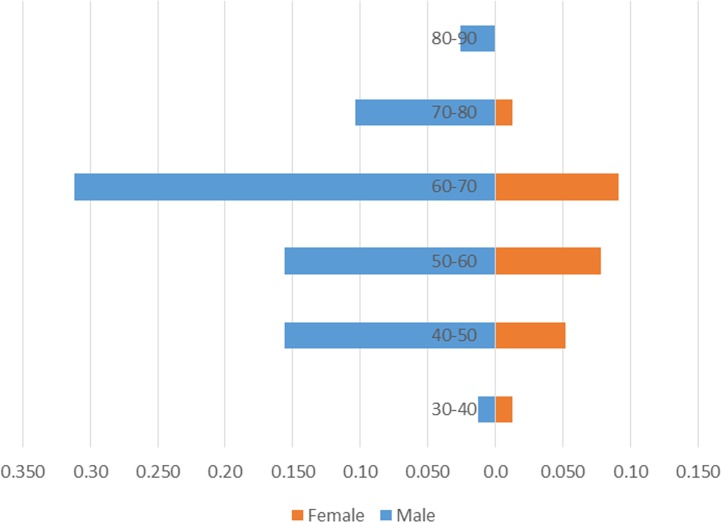
Age and sex distribution of the 77 patients with PIOSCC.